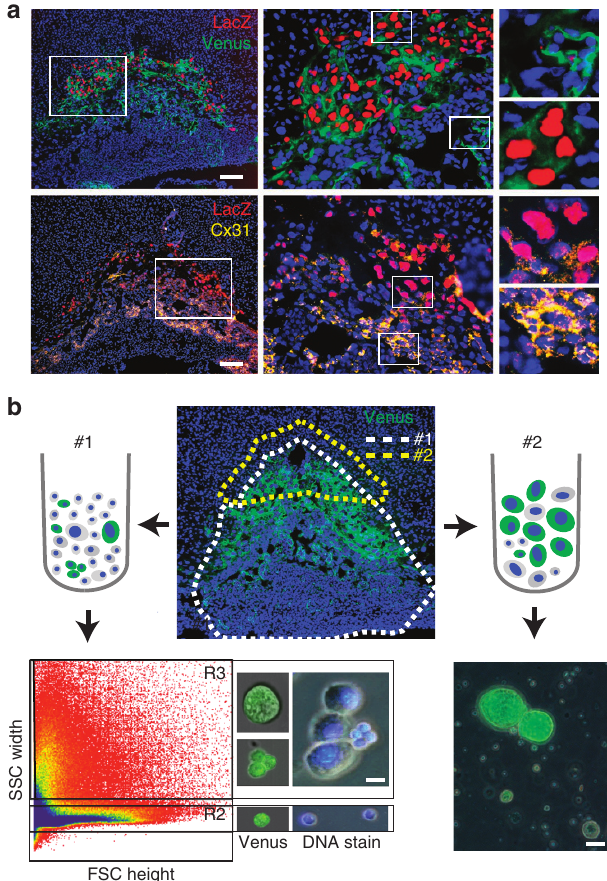
Figure 1 | Strategies for isolation of single cells for scRNA-seq. ( a ) Expression patterns of paternally inherited Prdm1 LacZ knock-in and Prdm1-Venus transgenic reporter alleles at E9.5 substantially overlap (top). Cx31 is broadly expressed in diploid trophoblasts including LacZ þ diploid, but is undetectable in mature TGCs (bottom). Bar, 200 m m. ( b ) Cell isolation protocols for recovery of Prdm1 þ subpopulations. Bar, 10 m